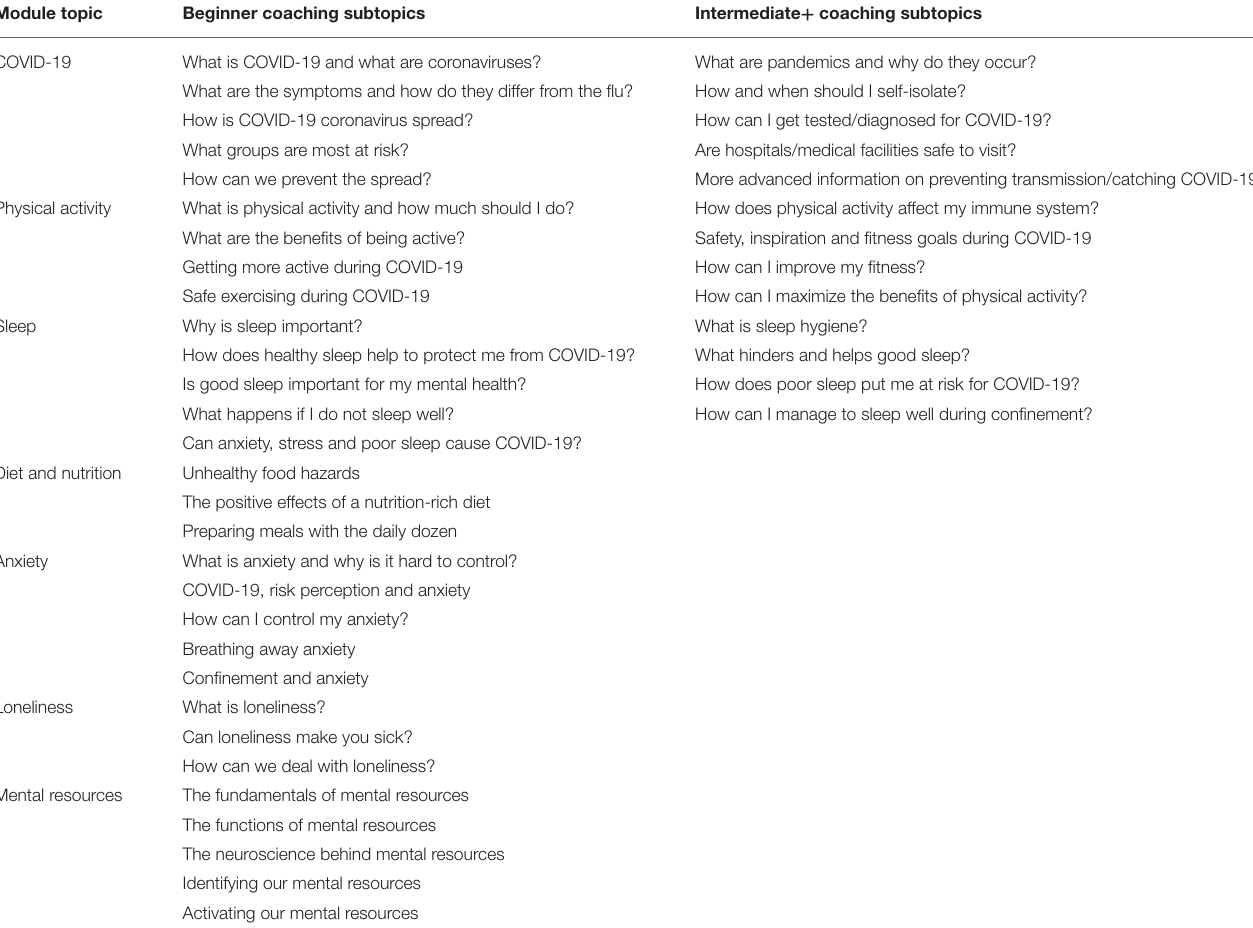
TABLE 1 | Coaching topic